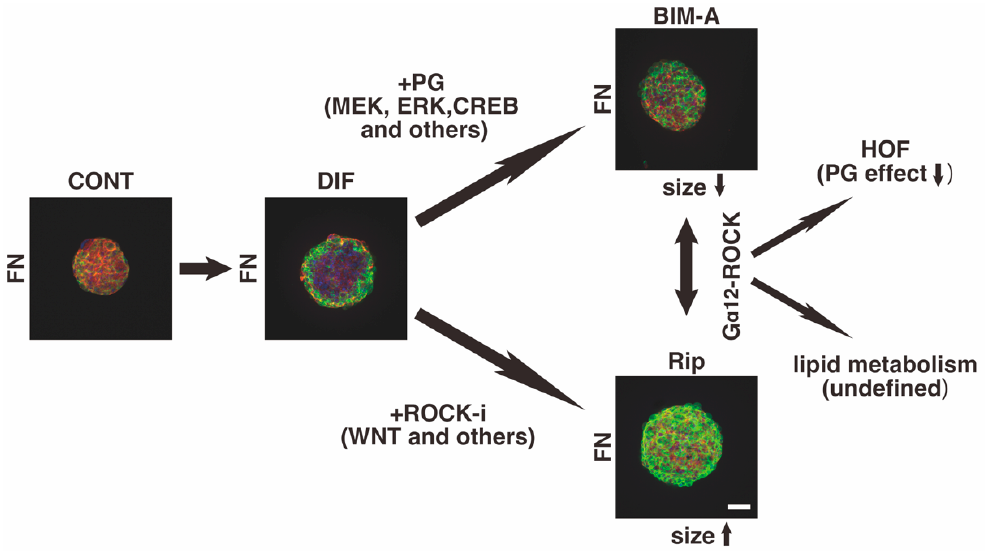
Figure 1. Hypothetical schema of PG and/or ROCK-i induced signaling toward 3D 3T3-L1 spheroids and experimental setups for the present study.